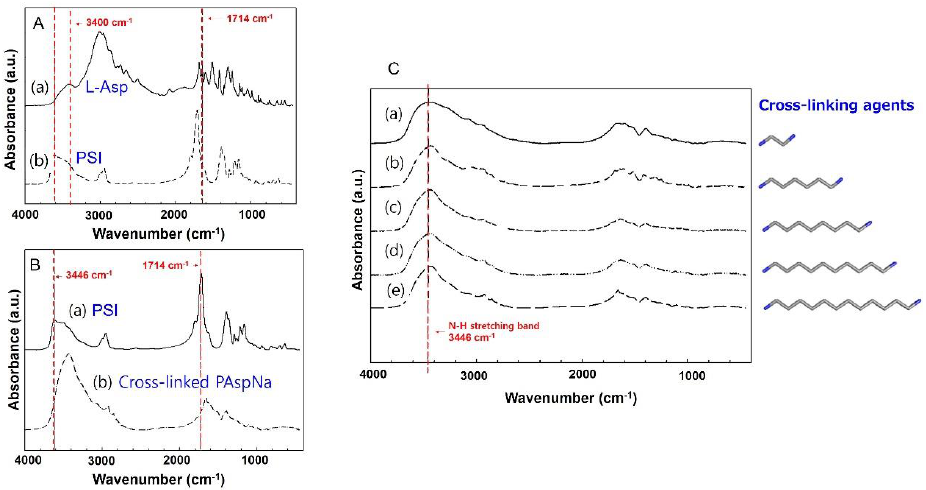
Figure 3. FT-IR spectra of ( A (a)) L-Asp, ( A (b)) PSI, ( B (a)) PSI, ( B (b)) cross-linked PAspNa samples with different cross-linked agents: ( C (a)) ethylene diamine, ( C (b)) 1,6 − hexamethylenediamine, ( C (c)) 1,8 − diaminooctane, ( C (d)) 1,10 − diaminodecane, ( C (e)) 1,12 −